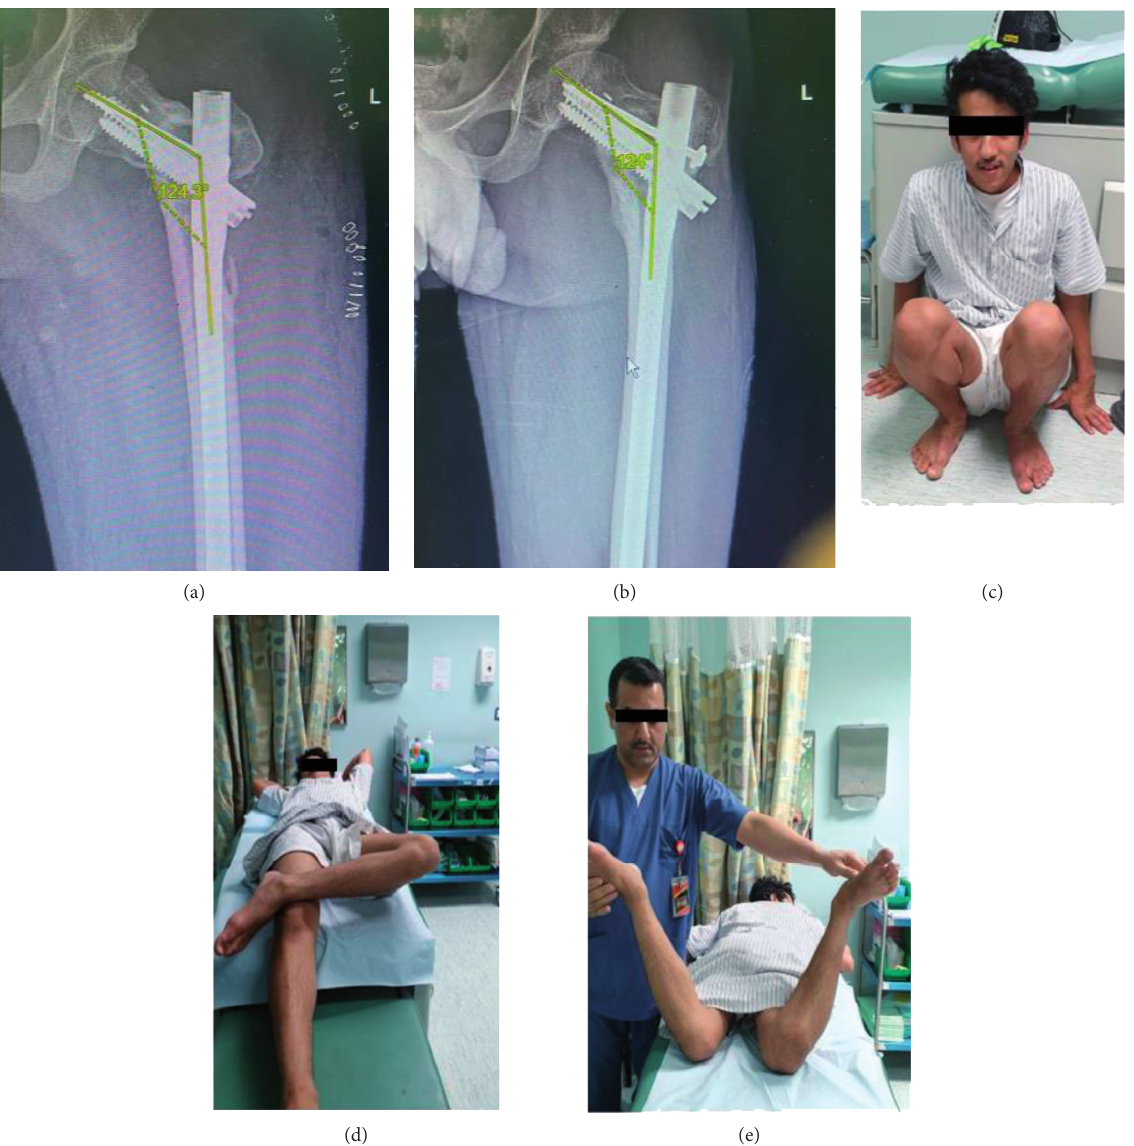
Figure 3: (a) Postoperative radiograph sequence showing correction achieved and the position of implant within the femoral head and intramedullary canal. (b) 6 months postoperative follow-up showing 124 degree neck-shaft angle. (c) 4 months postoperative clinical photo showing the ability of the patient to squat. (d) External rotation (cross leg). (e) Internal